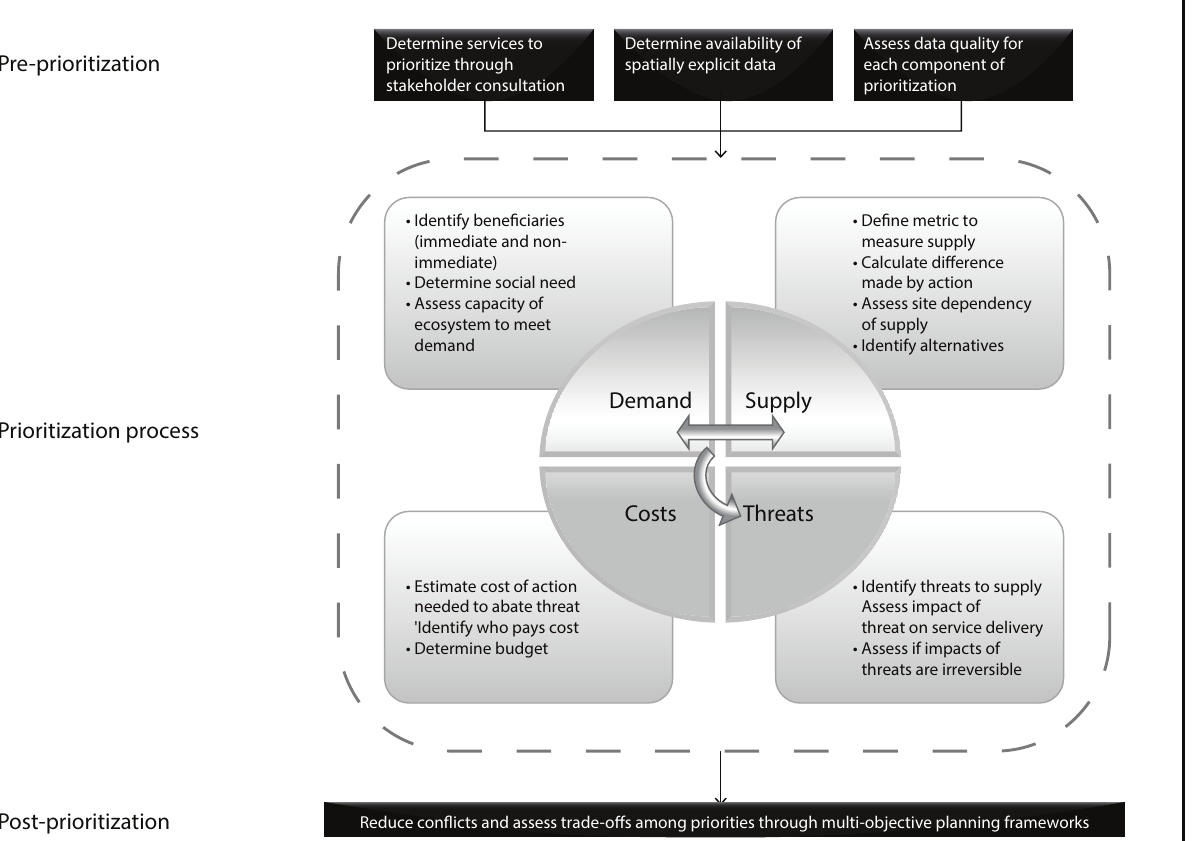
Figure 1. Key aspects for consideration in ecosystem-service